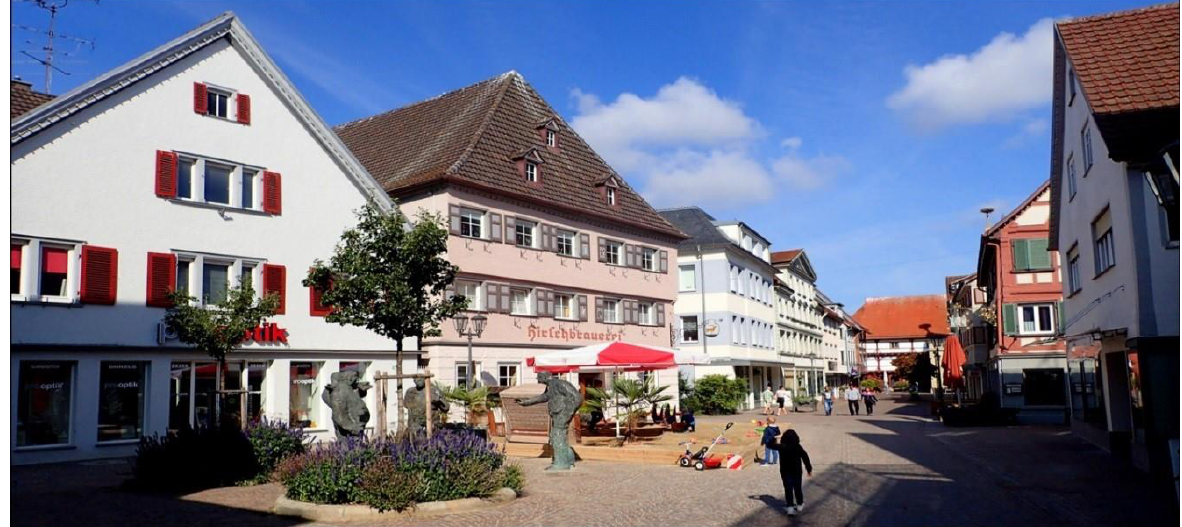
Figure 2. The densely-placed downtown development of Bad Saulgau